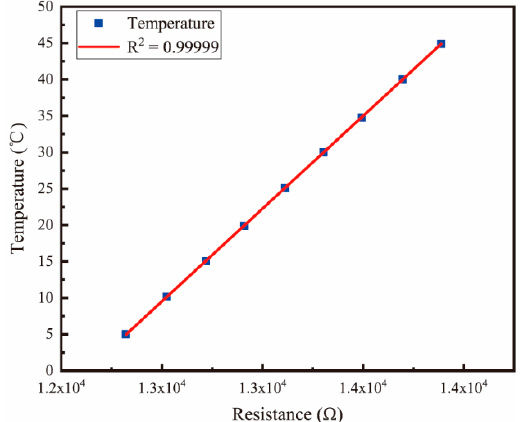
Figure 10. Variation in the resistance of platinum film resistor with temperature.